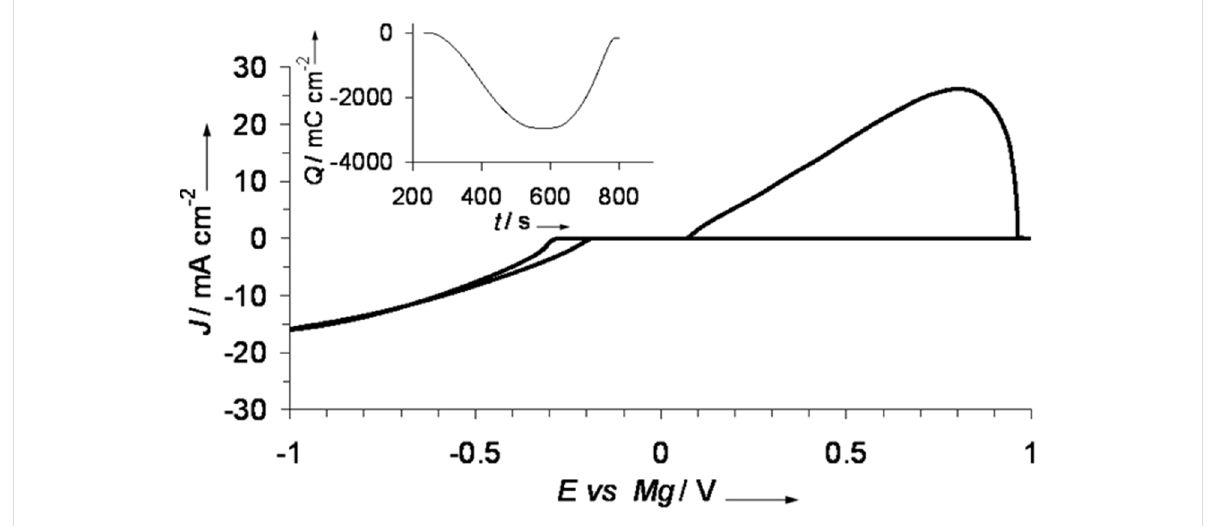
Figure 4: Cyclic voltammogram for LiBH 4 (0.6 M)/Mg(BH 4 ) 2 (0.18 M) in DME, (inset shows deposition/stripping charge balance). Reprinted from [27] with permission. Copyright © 2012, Wiley-VCH Verlag GmbH & Co. KGaA, Weinheim.